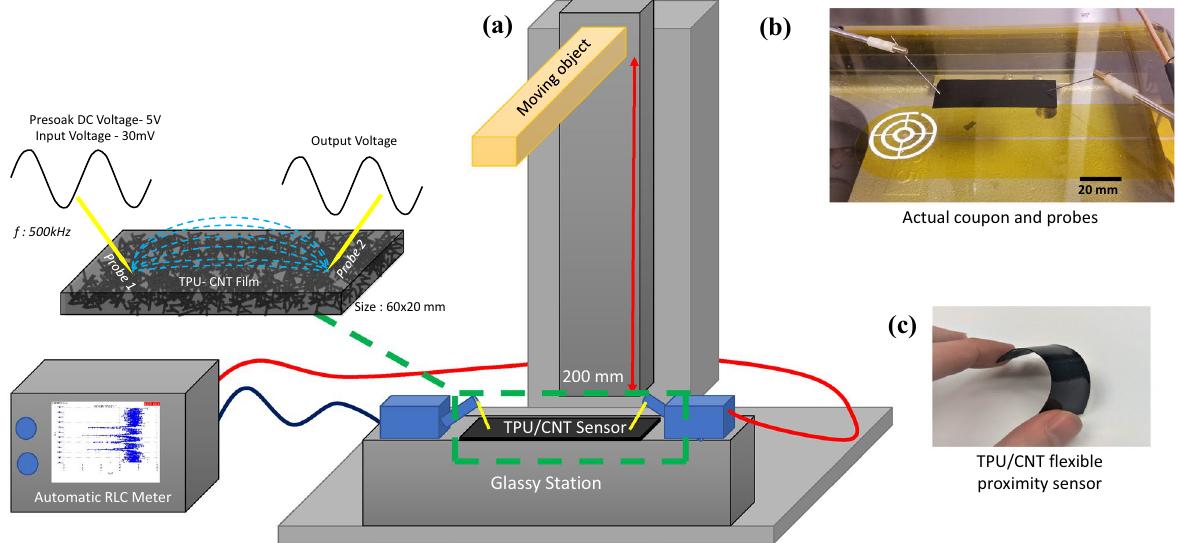
Figure 1. Schematic illustration of a TPU/CNT proximity sensor setup. ( a ) Distances ranging from 220 to 20 mm were applied by using a probing station (Keithley 4200-SCS, Tektronix, USA). The film was fixed over a glassy substrate to eliminate the noise and the sensing object (brass bar-10 × 20 × 200 mm) approached the sample with a speed of 6.6 mm/s (Video S1). To detect the maximum change in the capacitance, the samples were pre-soaked with 5 V direct current (DC) to saturate and reduce the tunneling effect. Furthermore, a 30 mv alternate current (AC) swiping signal was applied to measure the capacitance of the film with varying frequencies. Negative change plot in capacitance showing sensitivity on RLC meter screen. ( b ) The sensor probes were mechanically semi-planner with an angle of 45° to reduce noise and the penetration depth inside the film. ( c ) Sensor being bent to show the thickness and the